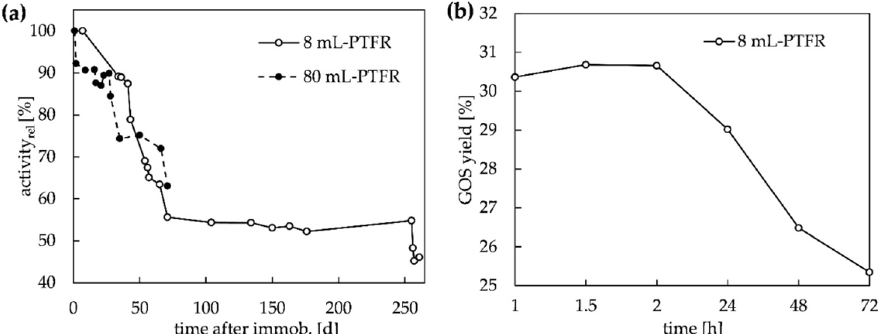
Figure 6. ( a ) relative enzyme activity of immobilized β -gal in 8 mL-PTFR (flow = 10 mL min − 1 ) and 80 mL-PTFR (flow = 20 mL min − 1 ) with semi-continuous configuration and ( b ) GOS yield of the continuous configuration with recirculation for the 8 mL-PTFR over 72 h (p1 = 0.5 mL min − 1 , p2 = − 1 9.5 mL min − 1 ). p2 = 9.5 mL min